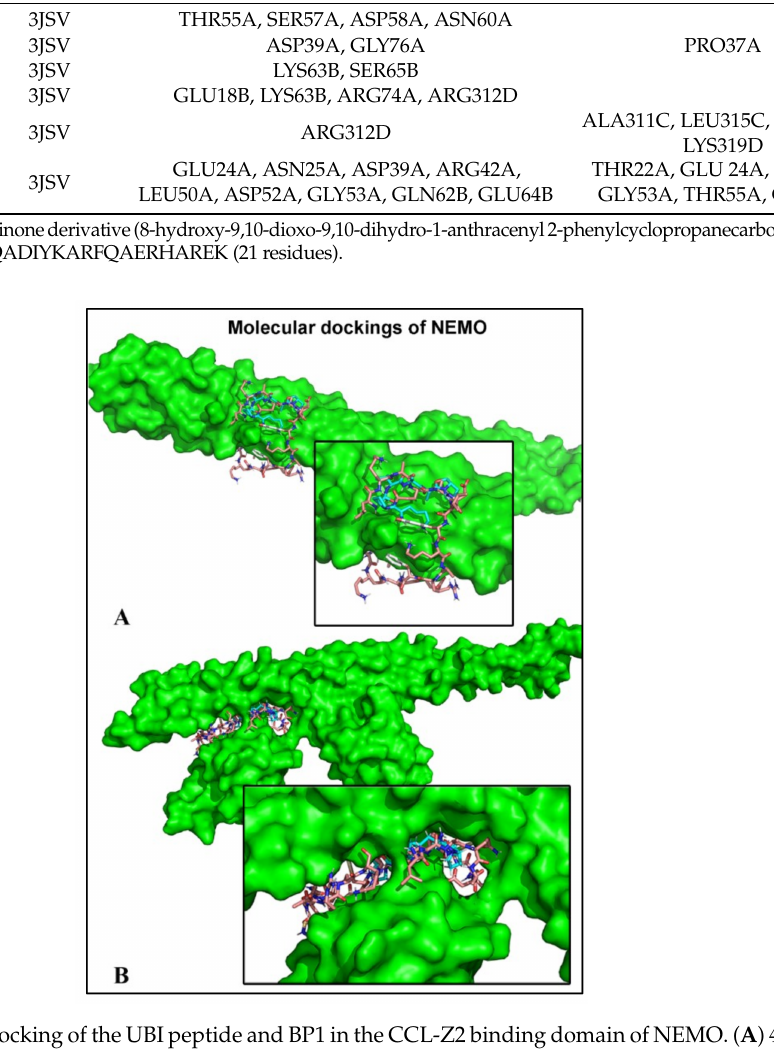
Figure 4. Blind docking of the UBI peptide and BP1 in the CCL-Z2 binding domain of NEMO. ( A ) 4BNW without linked ubiquitins. ( B ) 3JSV complexed with Lys 63-linked poly-ubiquitin. The superposition of UBI peptide and BP1 (in blue) is shown. In silico docking calculations support the potential binding of the four distinct BP, which could impair IKK recruitment through competition with the Lys63-linked